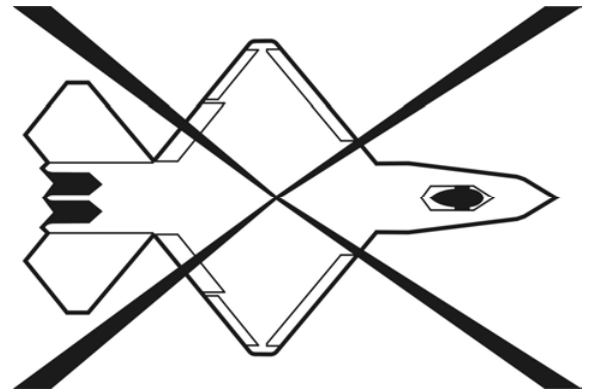
Fig 12. The edges, panels, and major brakes in the surfaces have to be grouped on a minimum number of alignments. These helps to ensure that radar will see the strongest edge reflections only at four relatively narrow azimuth zones. This will give the illuminating radar one good return when alignment is ideal, but a much weaker return on subsequent sweeps. After R. Whitford [34]